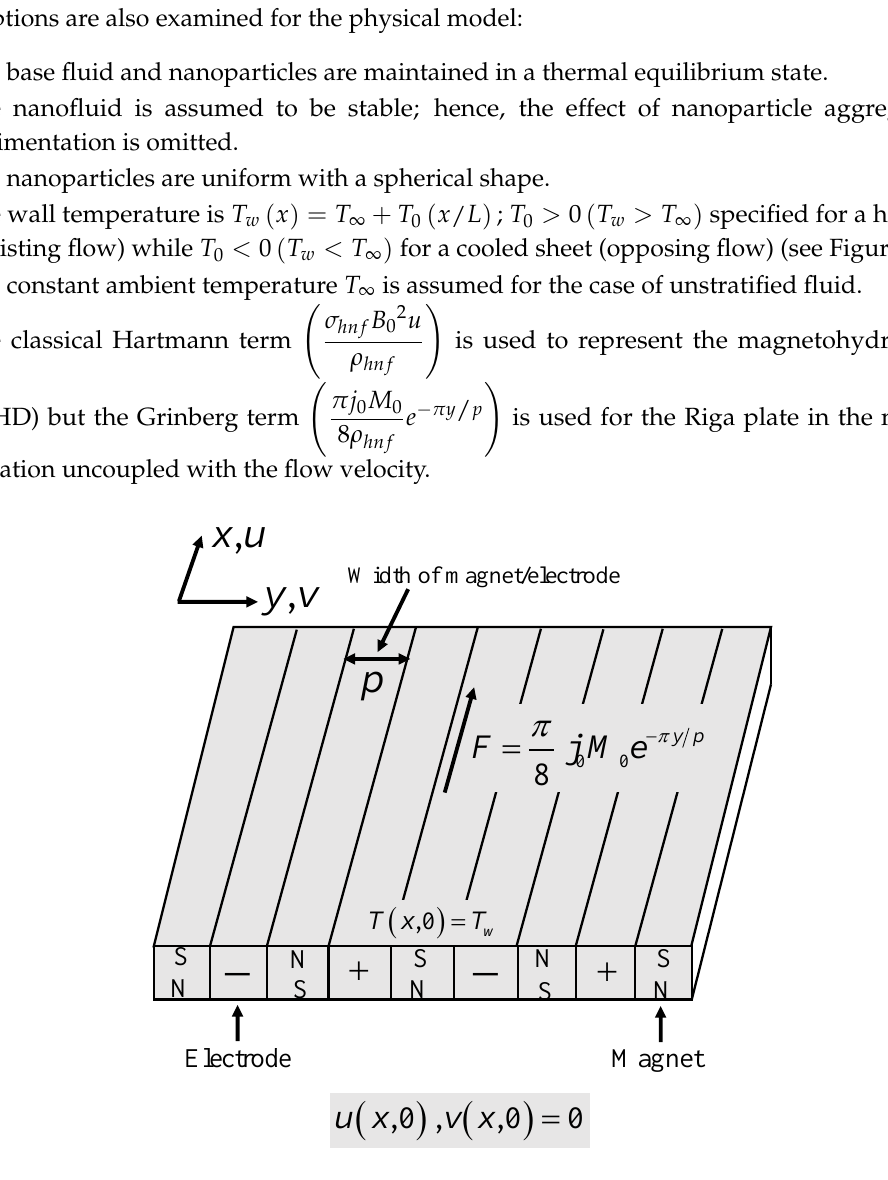
Figure 1. An illustration of the Riga